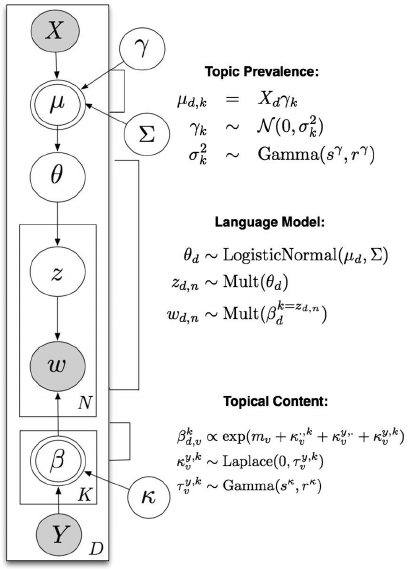
Figure A2. Structural topic modeling, in plate notation, in: (Roberts ME, Stewart BM, Tingley D, Airoldi EM. The structural topic model and Applied Social Science 2013).